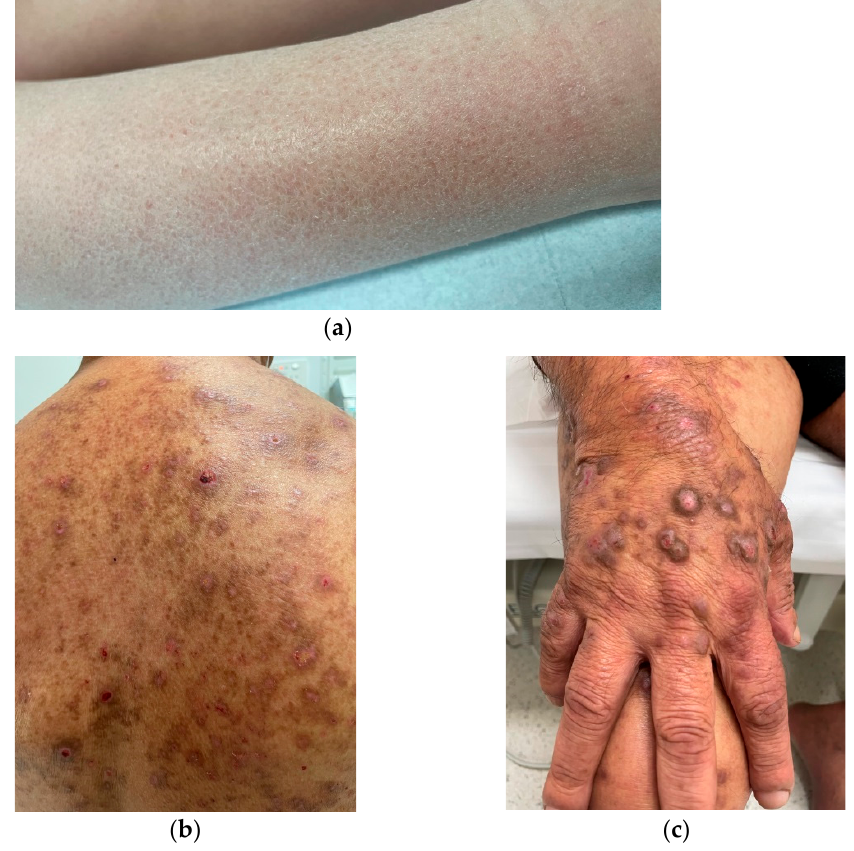
Figure 2. Potential skin lesions in CKDaP. ( a ) Xerosis. ( b , c ) Widespread prurigo nodularis, excoriations, ulcerations, and post-inflammatory hyperpigmentation.